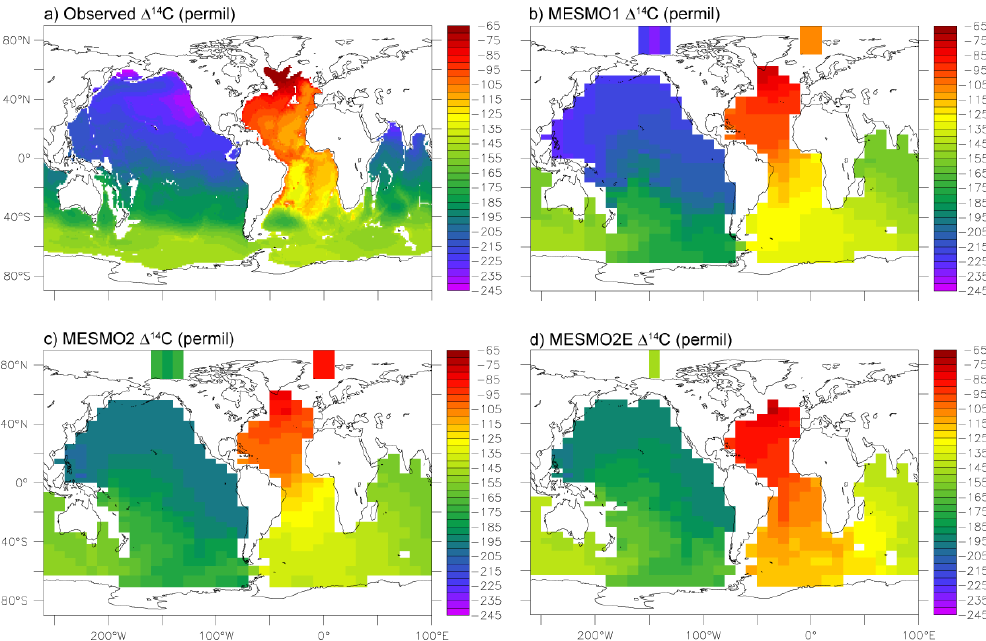
Fig. 3. Observed and model-simulated natural 1 14 C from 2500–5000m water depth. Observations are based on WOCE data (Key et al.,